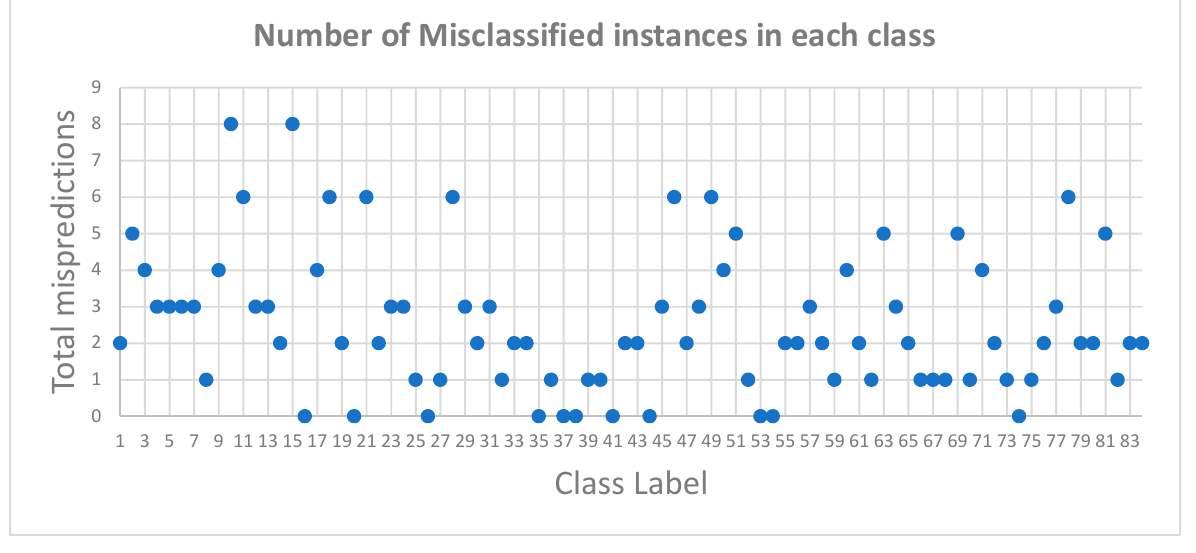
Figure 5. Scatter graph showing classes misclassified as other classes.